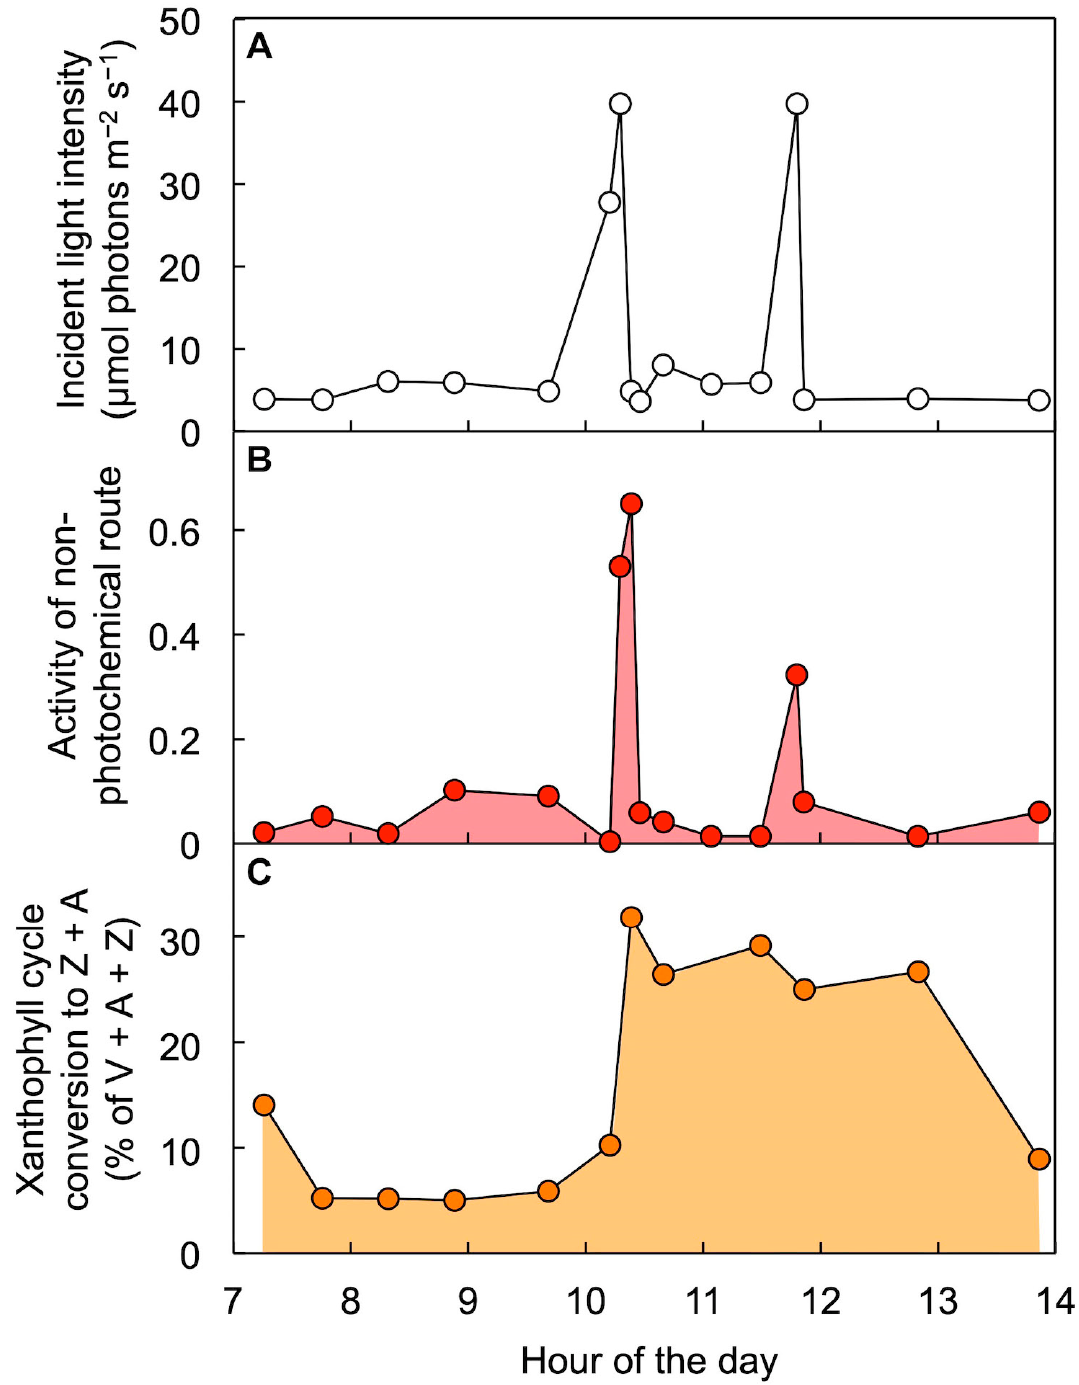
Figure 10. Diurnal characterization of ( A ) light incident on the upper leaf surface, ( B ) level of energy dissipation via a regulated non-photochemical route (quantified from chlorophyll fluorescence as Stern–Volmer quenching), and ( C ) percent of the xanthophyll cycle pool present as zeaxanthin + antheraxanthin (Z + A) in leaves of Alocasia brisbanensis in the understory of a subtropical rainforest (Dorrigo National Park, New South Wales, Australia). V = violaxanthin. Data are from Logan et al. [68].